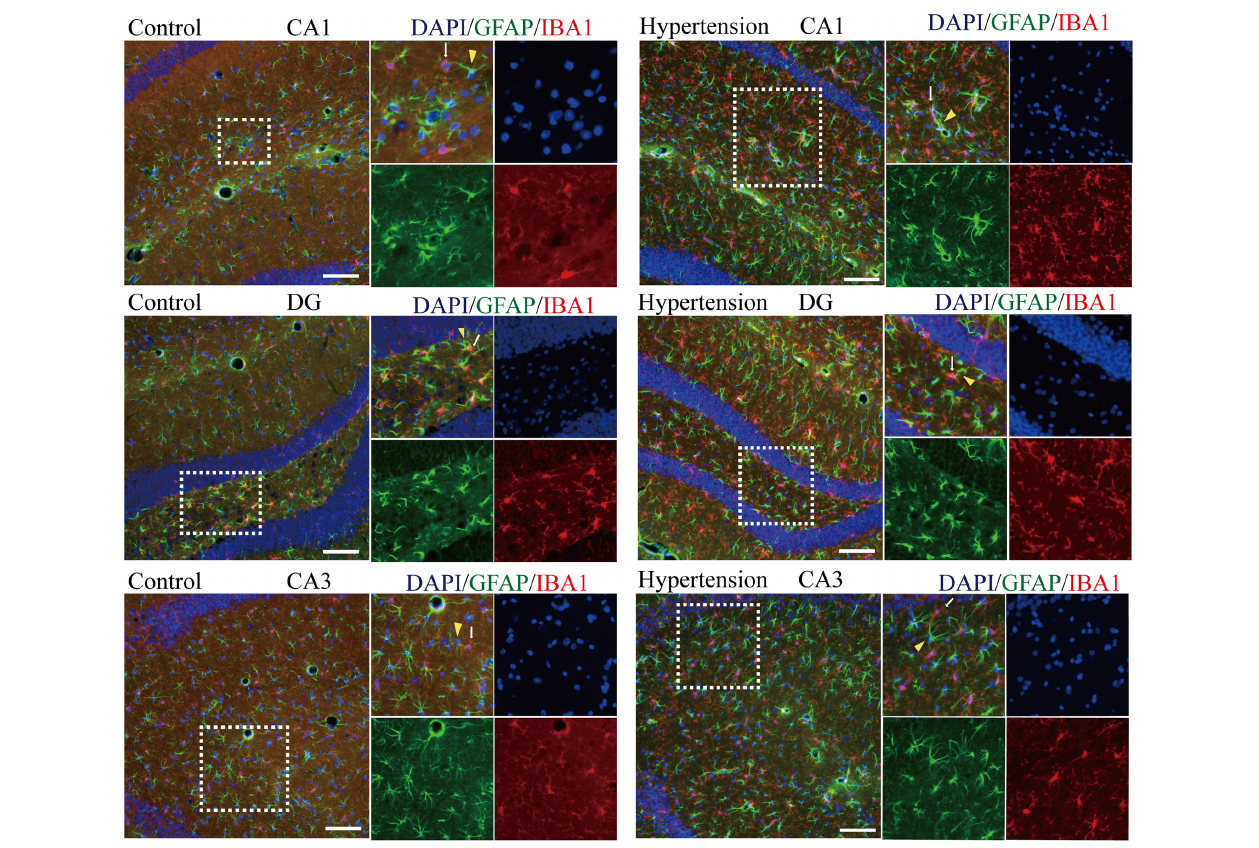
FIGURE 6 | Determination of spatial colocalization of microglia and astrocytes after 30 days of angiotensin II treatment in middle-aged mice. Representative images of immunofluorescence double-staining with anti-GFAP (green) and anti-IBA1 antibodies (red) in the hippocampus (CA1, DG, and CA3) of the mice in the control and hypertension groups (immunofluorescence, × 20, scale bar = 100 µ